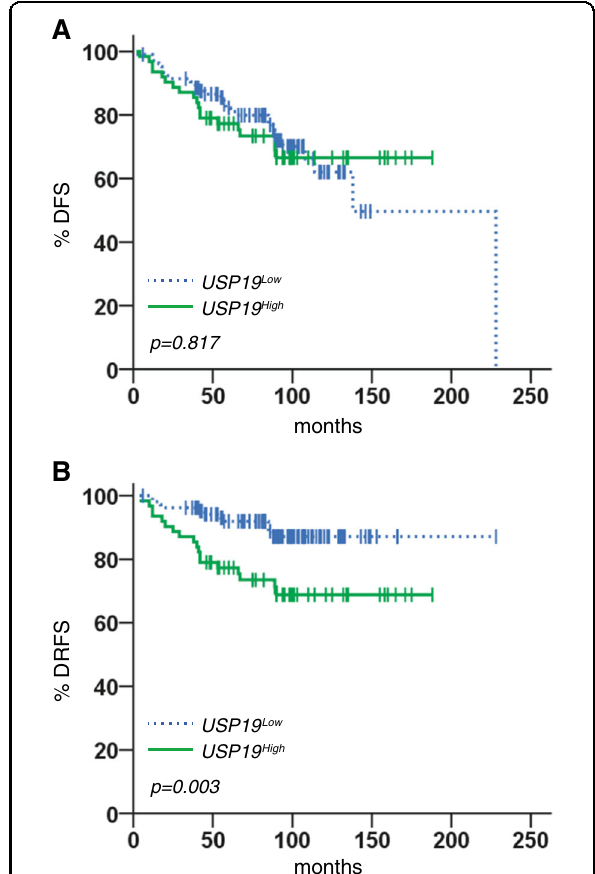
Fig. 7 Prognostic value of USP19 protein expression in breast cancer patients. Kaplan – Meier estimates of disease-free survival (DFS) and distant relapse-free survival (DRFS) in patients with early breast cancer tumors, according to high (solid green lines) and low (dashed blue lines) expression of USP19. A 19 out of 62 patients (30.6%) harboring USP19 High tumors and 30 out of 106 patients (28.3%) with USP19 Low tumors had a disease relapse ( n = 168, Log-Rank (Mantel- Cox) test, p = 0.817). B Distant metastases developed in 18 out of 62 (29.0%) and 11 out of 106 (10.4%) of patients with USP19 High and USP19 Low tumors, respectively ( n = 168, Log-Rank (Mantel-Cox) test, p =